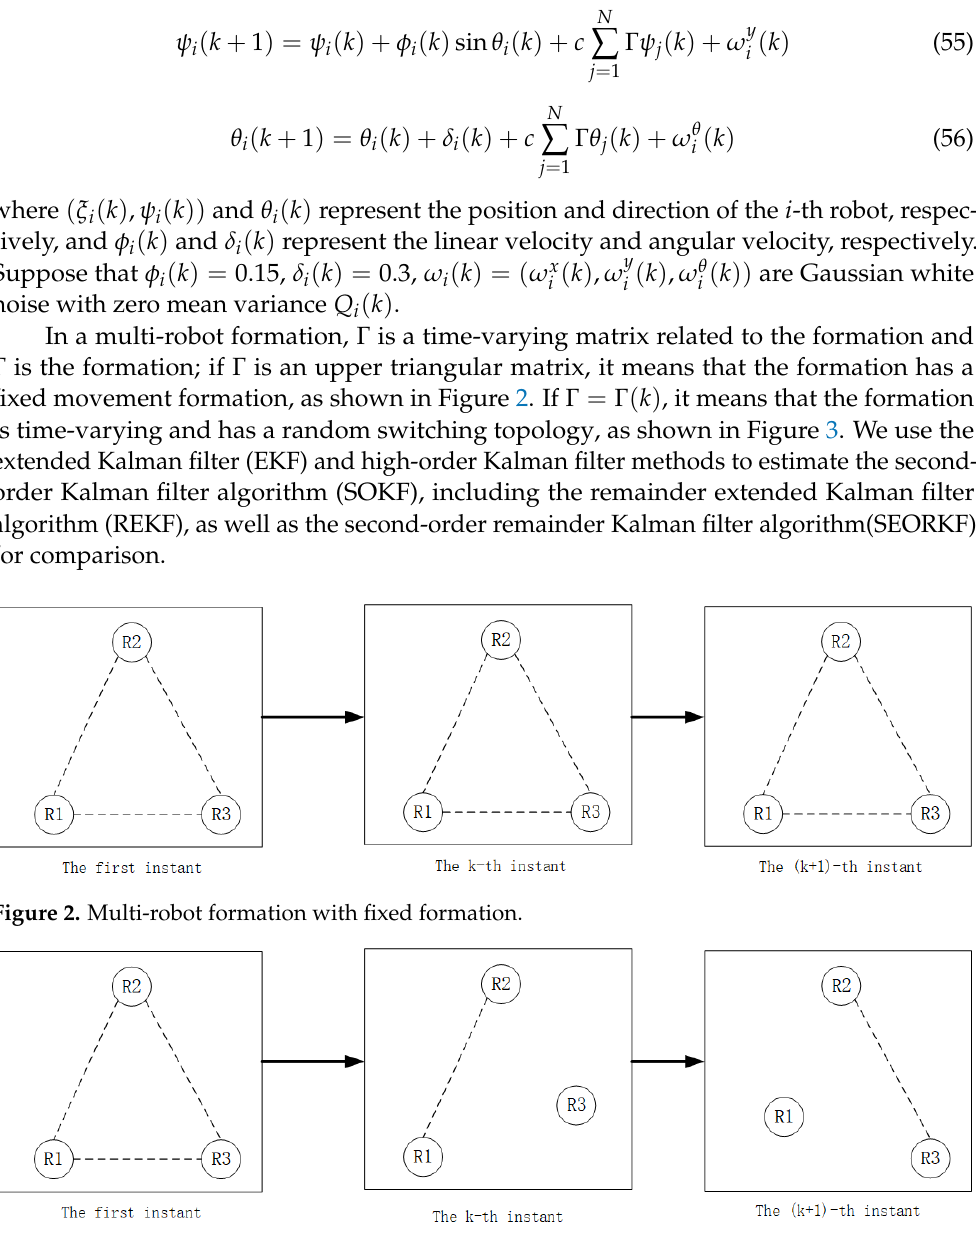
Figure 3. Multi-robot formation in a random topology